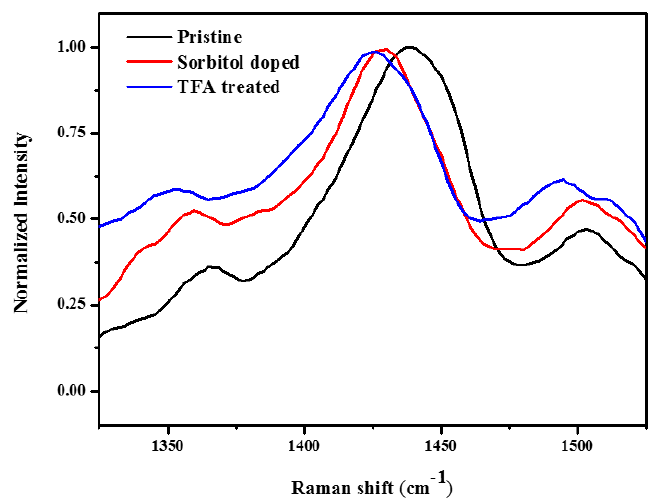
Figure 5. The Raman spectra of the pristine, the Sorbitol added PEODT: PSS solution, and the TFA treated PEDOT:PSS films.